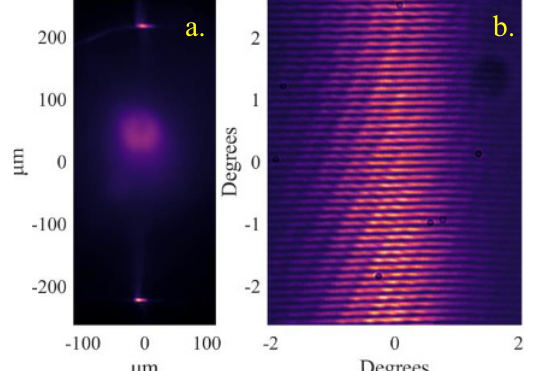
Fig. 2. MQWL (a) top down real space image, and (b) reciprocal space image that shows interference from the laser’s end facets.